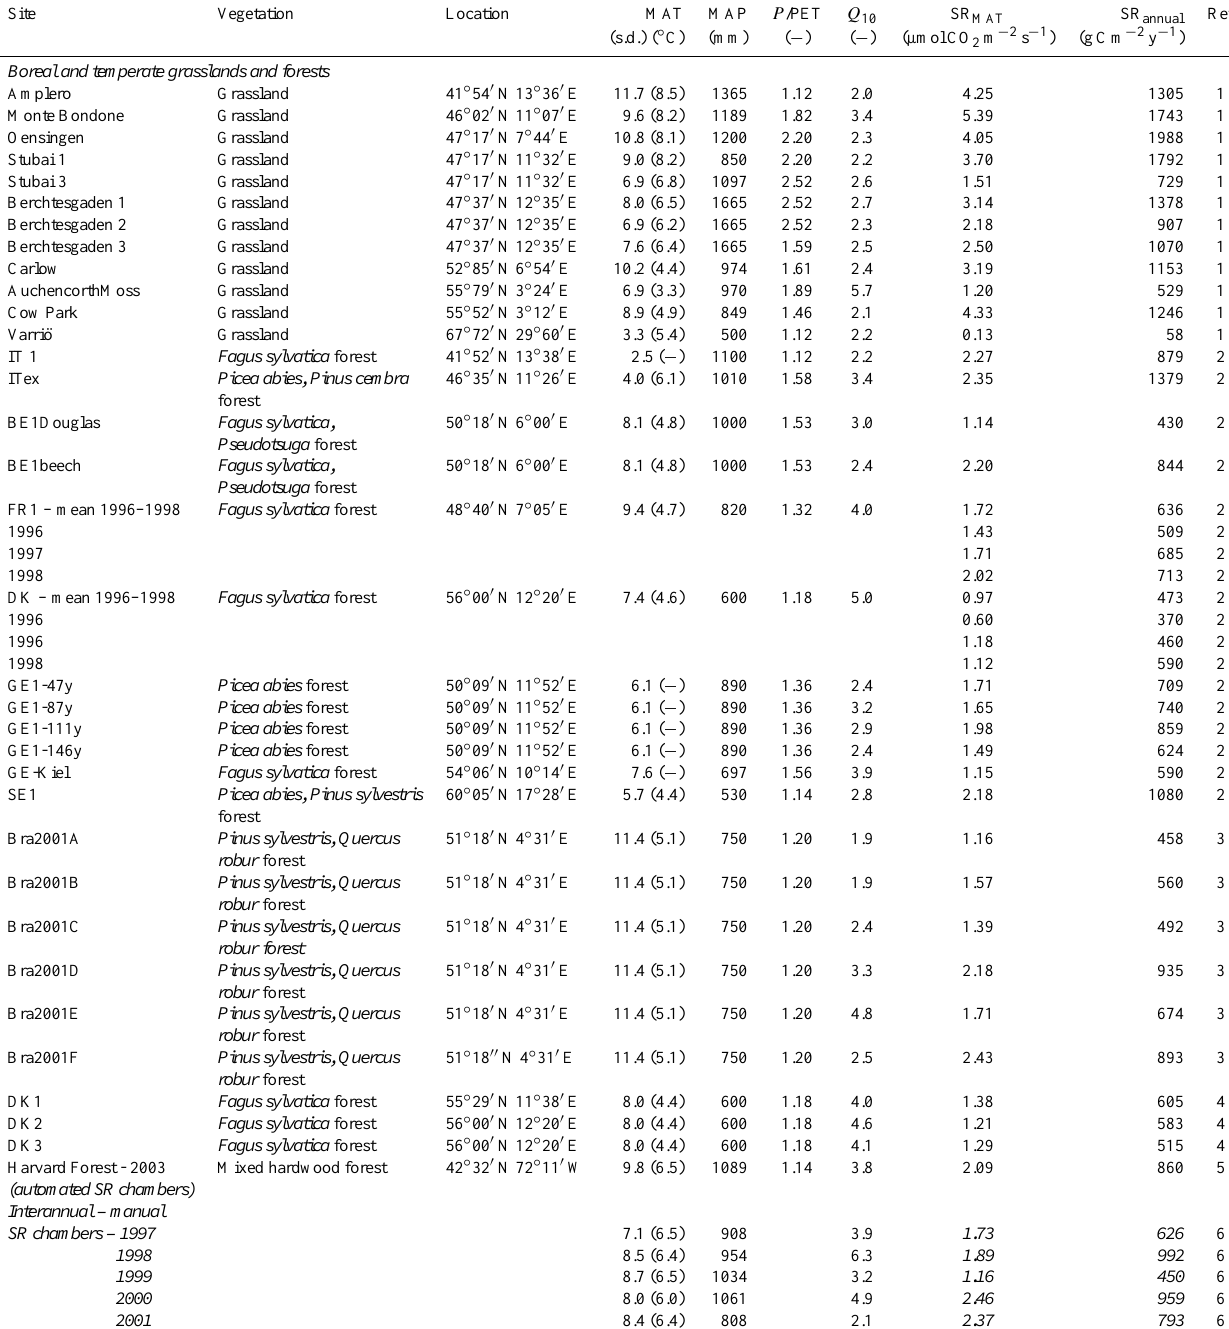
Table 1. Vegetation type, location, mean and standard deviation of annual soil temperature (as based on daily means), mean annual precip- itation (MAP), ratio of precipitation/potential evapotranspiration ( P /PET), as extracted from a global grid model, Q 10 of soil respiration, soil respiration at mean annual temperature (SR MAT – wet season values are set in italics) and annual soil respiration (SR annual ) for the sites included in this study. Sources: 1 ...Bahn et al., 2008; 2...Janssens et al., 2001 and 2003; 3...Curiel Yuste et al., 2004; 4...Janssens and Pilegaard, 2003; 5...Savage et al., 2009; 6...Davidson et al. 2006c, and some additional unpublished data from Savage and David- son; 7...Davidson et al., 2006b, and some additional unpublished data from Savage and Davidson; 8...Roupsard and Epron, unpublished ; 9...Salimon et al., 2004; 10...Davidson et al., 2008; 11...Davidson et al., 2000; 12...Nouvellon and Epron, unpublished; 13...Nouvellon and Epron, unpublished; 14...Misson, unpublished; 15...Gimeno et al., unpublished; 16...Tang and Baldocchi, 2005; 17...Wieser et al., 2009; 18...Carbone and Trumbore, unpublished; 19...Vargas and Allen, 2008; 20...Gr¨unzweig et al., 2009; 21...Talmon and Gr¨unzweig,